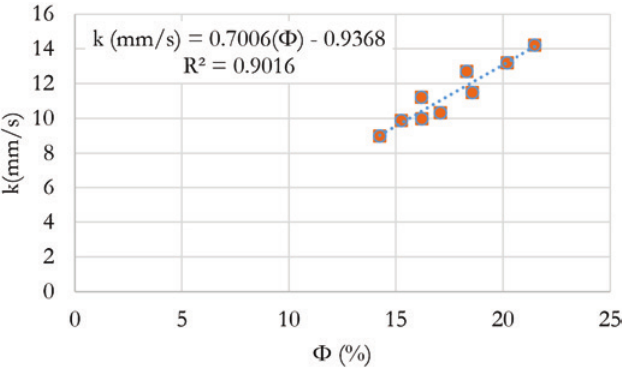
Correlação permeabilidade e índice de vazios Correlação F'c e k vs % de